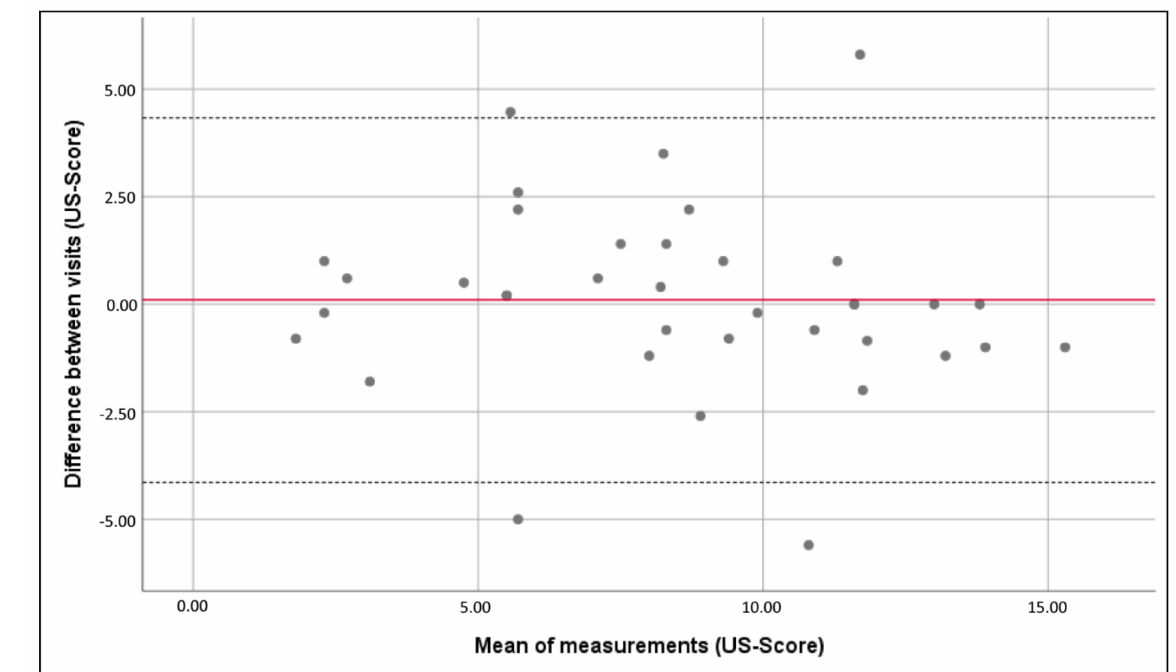
Figure 2. No visible trend in the distribution of the mean difference between visits (“US-Score”, dotted lines show 95%